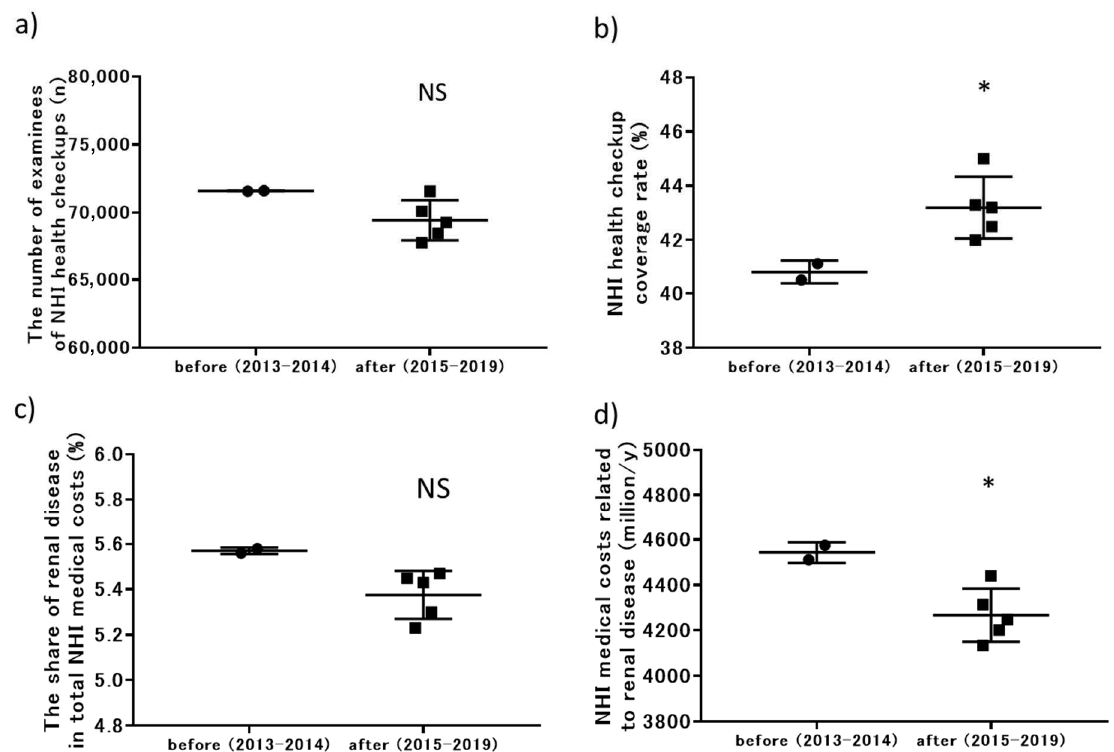
Figure 5. Changes in outcomes related to NHI before and after initiation of the prefecture-wide CKD initiative: ( a ) number of examinees who underwent NHI health checkups; ( b ) NHI health checkup coverage rates; ( c ) proportion of total NHI medical costs related to renal disease; ( d ) NHI medical costs related to renal disease. NHI, National Health Insurance; CKD, chronic kidney disease. * p < 0.05 versus before the initiative (2013–2014).